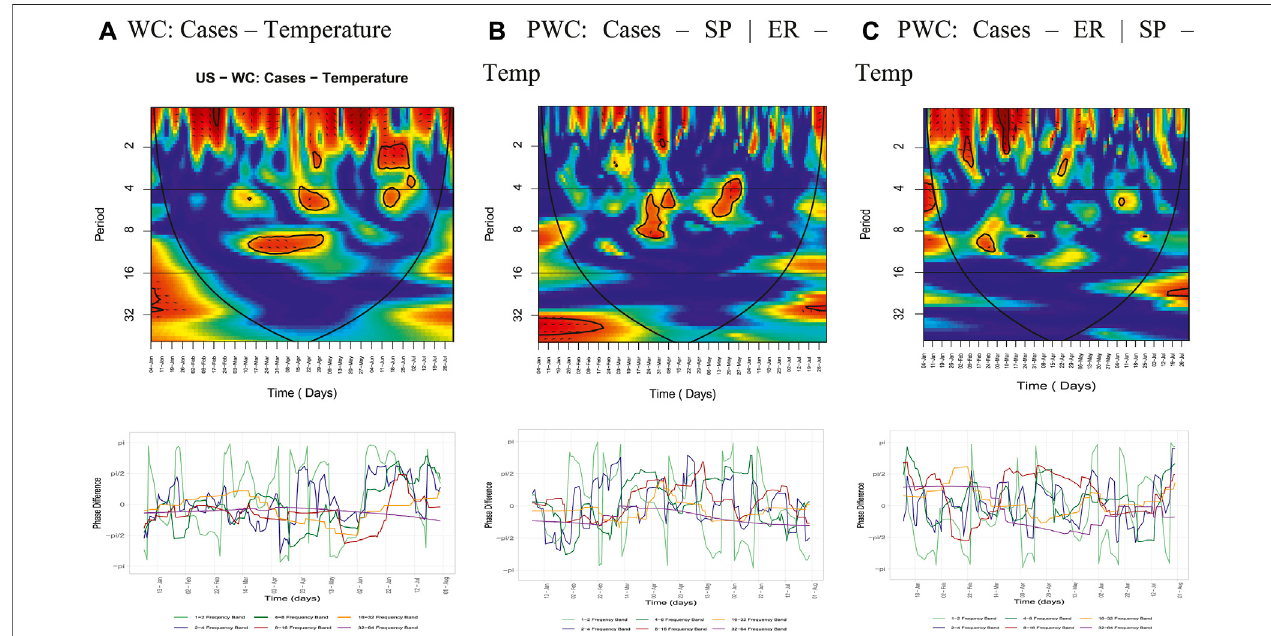
FIGURE 2 | United States (A) WC: Cases — Temperature. (B) PWC: Cases — SP | ER — Temp. (C) PWC: Cases — ER | SP — Temp.